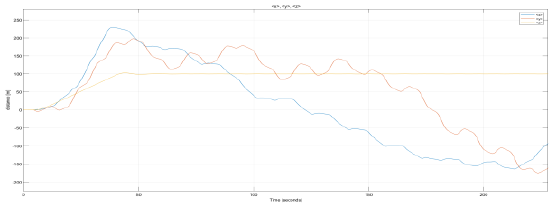
Figure 30. Q angular around Y - axes for the QAV